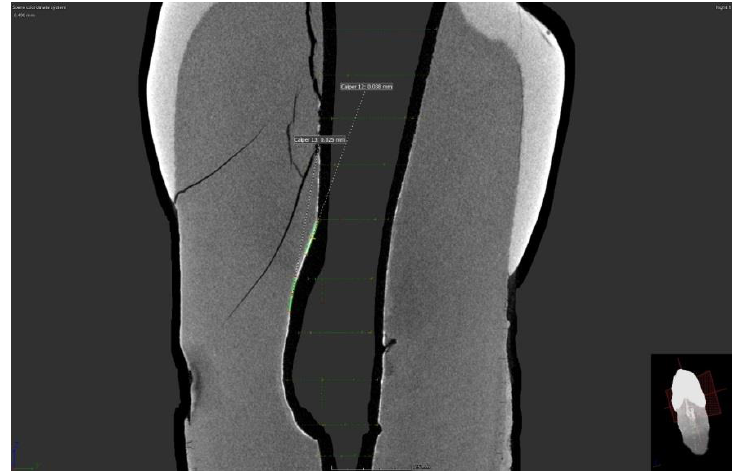
Figure 1. Micro CT scan of sample with removed smear layer.